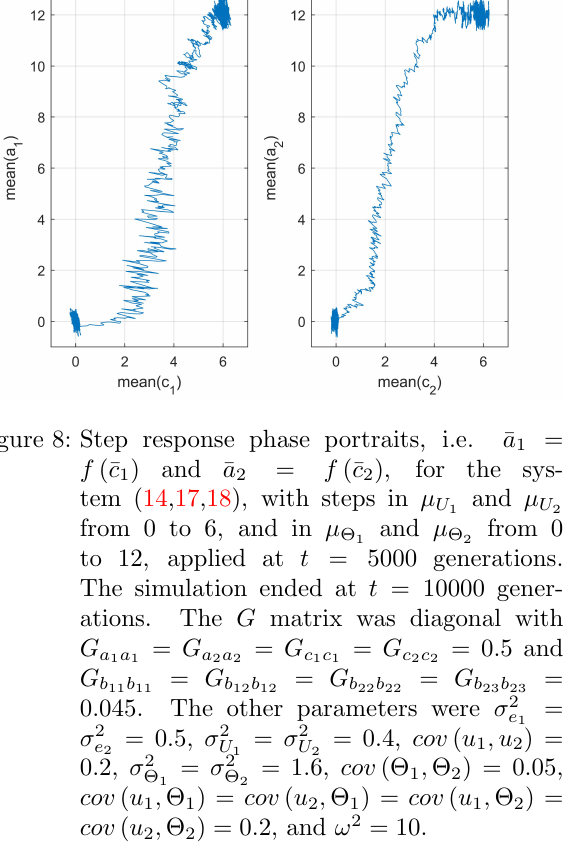
Figure 7: Mean fitness corresponding to the ramp re- sponses in Figure 6, for G cc = 0 . 5 (upper panel) and G cc = 0 (lower panel).